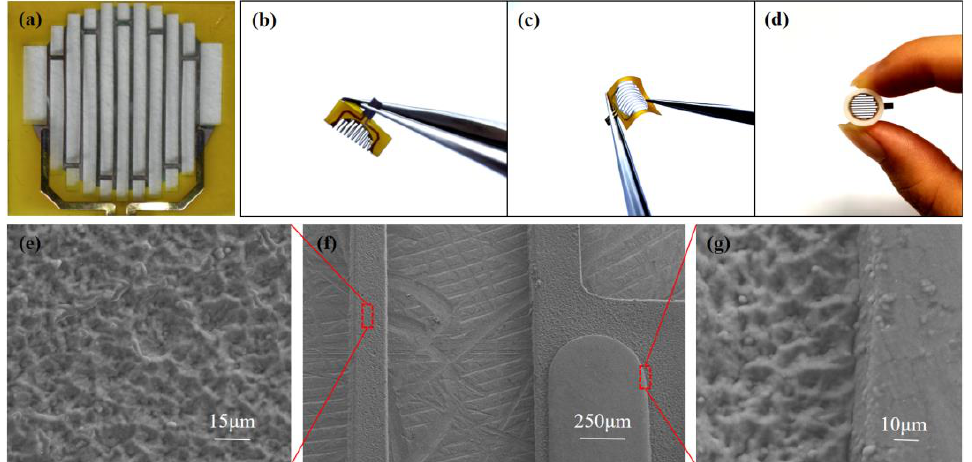
Figure 4. ( a ) Microscopic image of the perforated respiratory sensor. ( b ) 180-degree bend and ( c ) 90- degree bend. ( d ) Integrated picture. ( e , f ) SEM image of the perforated respiratory sensor. ( g ) SEM image of the connection between copper wire and platinum.